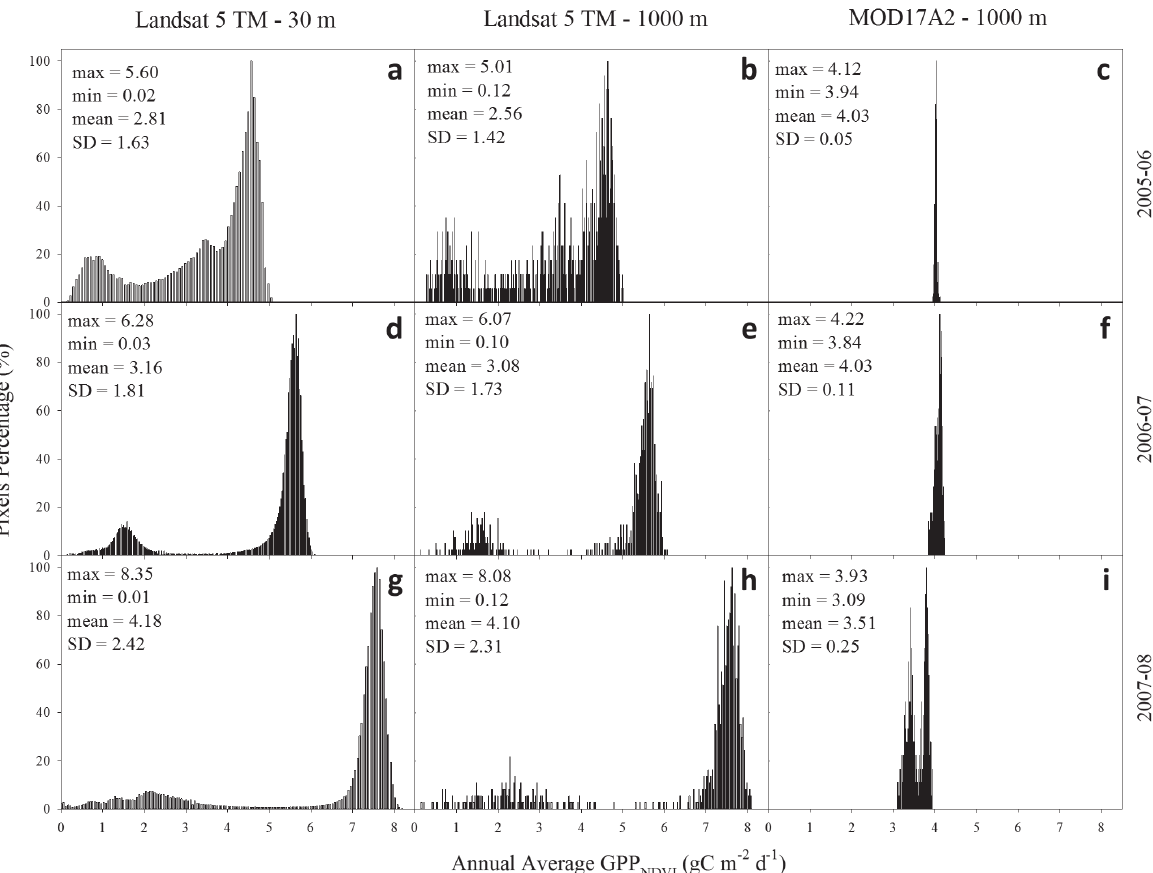
Fig. 8 - Histograms of maps of annual average GPP estimated from Vegetation Photosynthesis Model (VPM) using Normalized Difference Vegetation Index (NDVI) from Landsat 5 TM with 30 m ( a , d and g ) and 1000 m ( b , e and h ) of spatial resolution